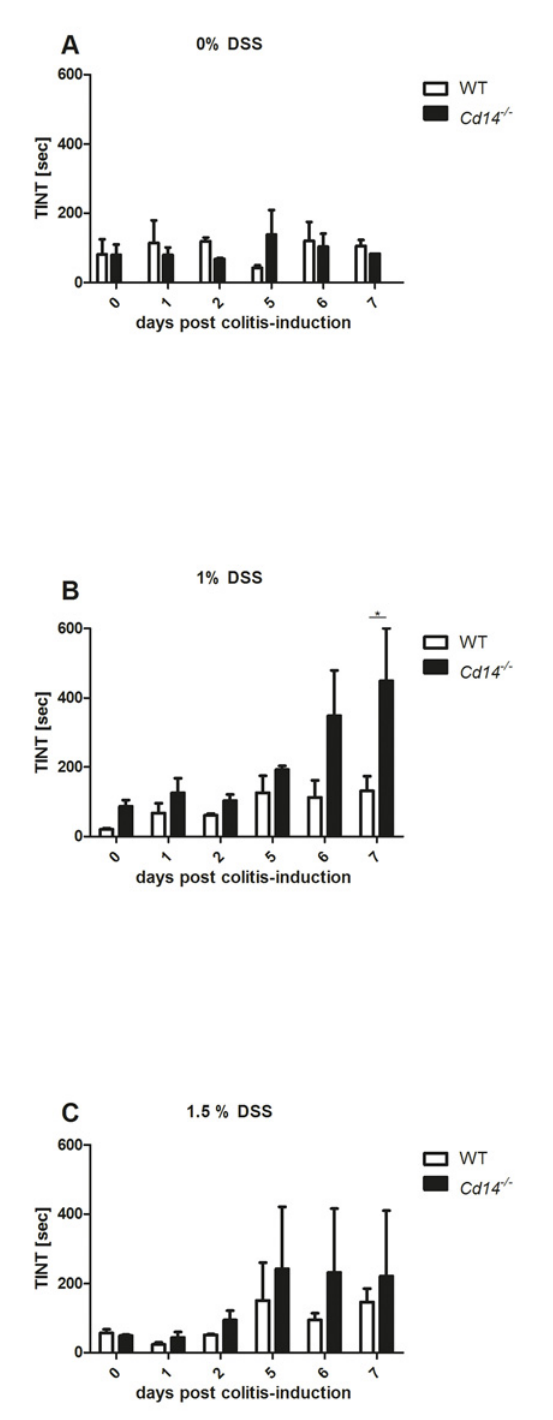
Fig 4. Colitis severity assessment by utilizing TINT. TINT time intervals determined in controls (A) and 1% (B) as well as 1.5% DSS treated mice (C). TINT time intervals were significantly increased in 1% DSS treated Cd14 -/- mice compared to WT mice on day 7 post colitis-induction (B).